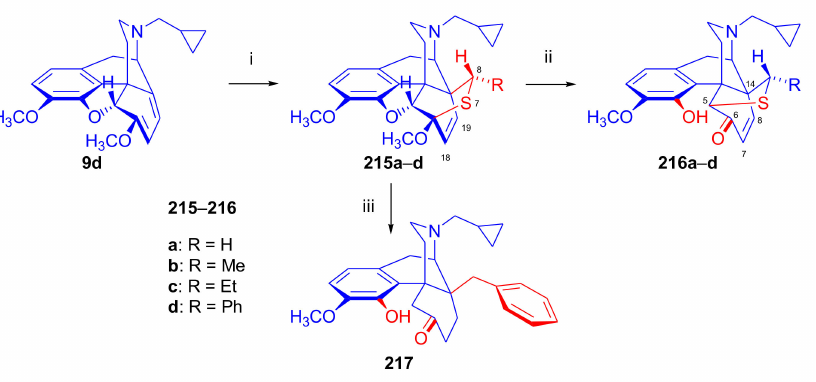
Figure 58. Synthesis of opiate antagonists with luteinizing hormone-stimulating properties. Reagents and conditions : (i): RCH 2 SS(O)CH 2 R, toluene, reflux, 1 h, 39–74%; (ii): 48% HBr, room temperature, 83–90%; and (iii): (1) Raney-Ni, MeOH, reflux, 23 h, (2) acetone, methanol, HCl, 45 ◦ C, 10 min.